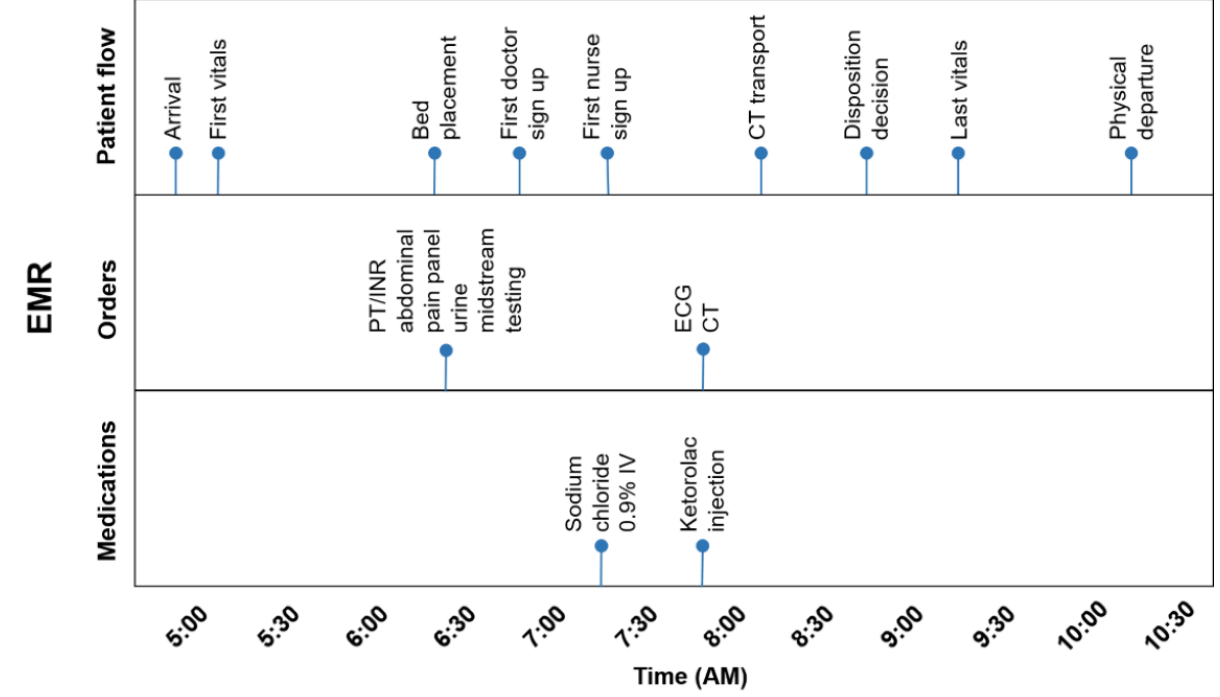
Figure 2. Example of emergency department visit information flow. CT: computerized tomography; ECG: electrocardiogram; EMR: Electronic medical record; IV: intravenous; PT/INR: Prothrombin time and international normalized ratio.